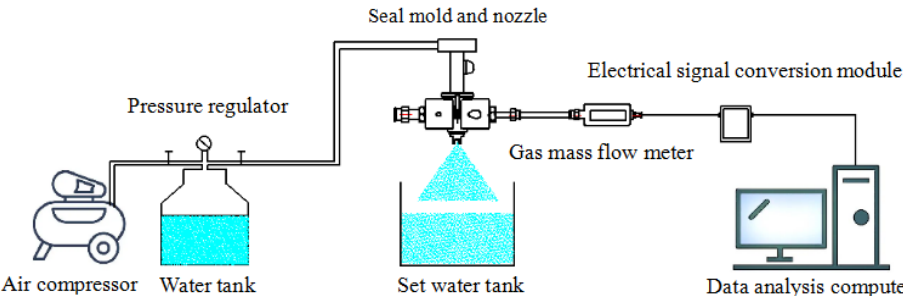
Figure 3. ALR measurement test.